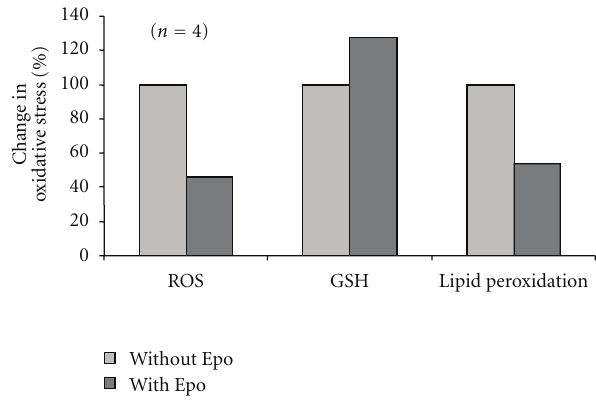
Figure 7: E ff ect of Epo on thalassemic mice. Heterozygous β - thalassemic intermedia (Hbb th 3 / + ) mice ( N = 4) with low hemoglobin levels (7–9g/dL) were inoculated (i.p) with Epo (5000U/kg). Before (Without Epo) and 2 hrs after (With Epo) injection, blood was drawn and RBC were assayed. The changes in the indicated parameters are shown. Values of untreated mice (Without Epo) were taken as